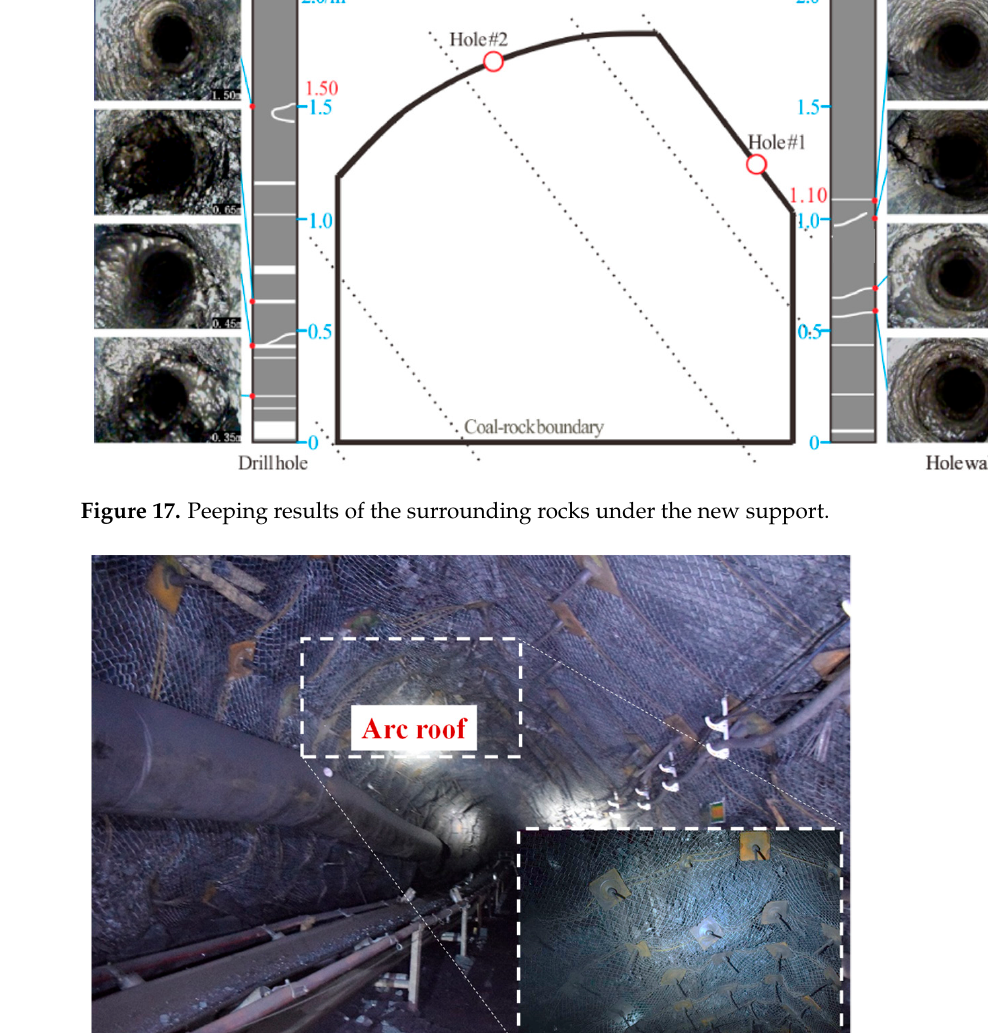
Figure 17. Peeping results of the surrounding rocks under the new support.